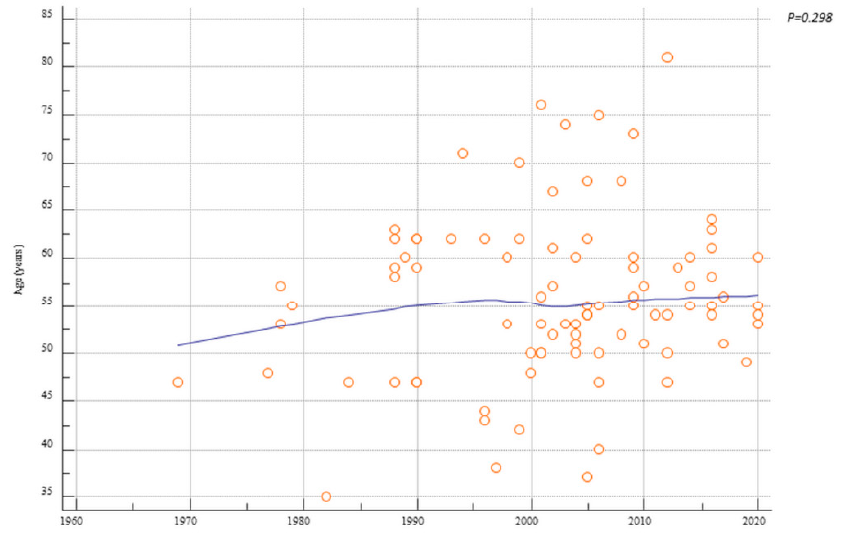
Figure 2. Scatter diagrams showing the trend over time of ( a ) previous endometriosis; ( b ) hormonal replacement therapy